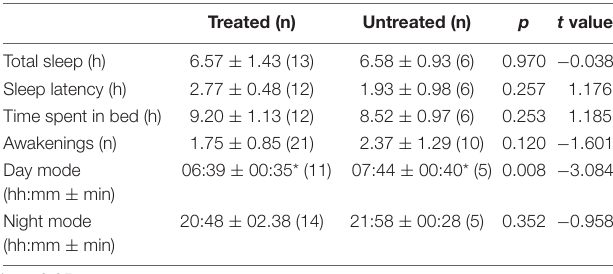
TABLE 3 | Actigraphic indices averaged over the first three days of